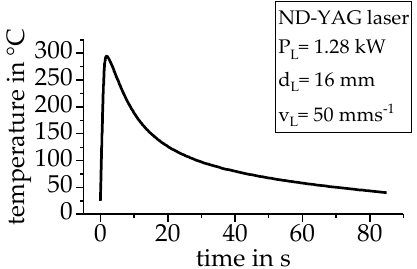
Figure 3. Time-temperature profile of a laser heat treatment at an aluminum extrusion profile with a wall thickness of 2 mm.